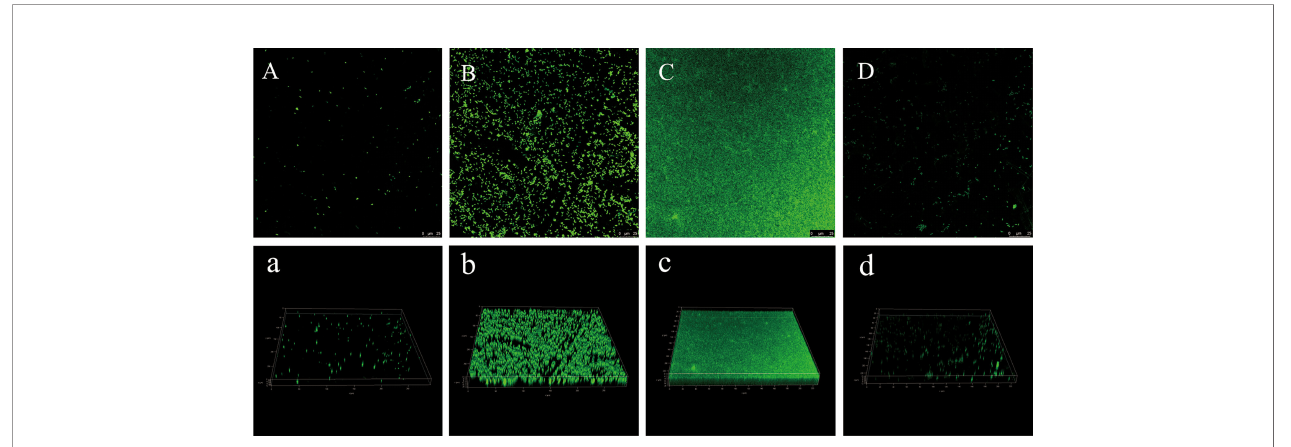
FIGURE 5 | CLSM images of V. parahaemolyticus bio fi lm at different times. (A/a) : 6 h. (B/b) : 18 h. (C/c) : 36 h. (D/d) : 60